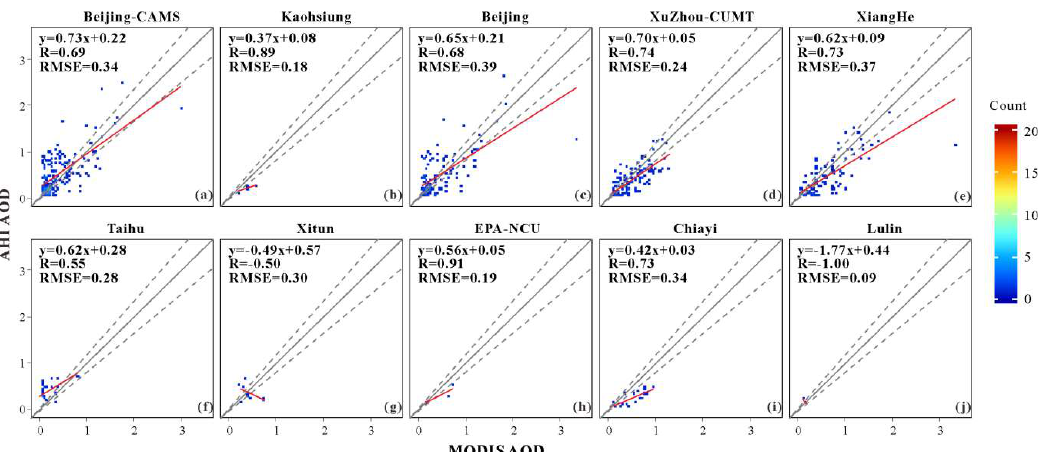
Figure 6. AHI against MODIS AOD retrievals at 500 nm for 10 sites (Beijing-CAMS ( a ), Kaohsiung ( b ), Beijing ( c ) XuZhou-CUMT ( d ), XiangHe ( e ), Taihu ( f ), Xitun ( g ), EPA-NCU ( h ), Chiayi ( i ) and Lulin ( j )) with valid collocations.